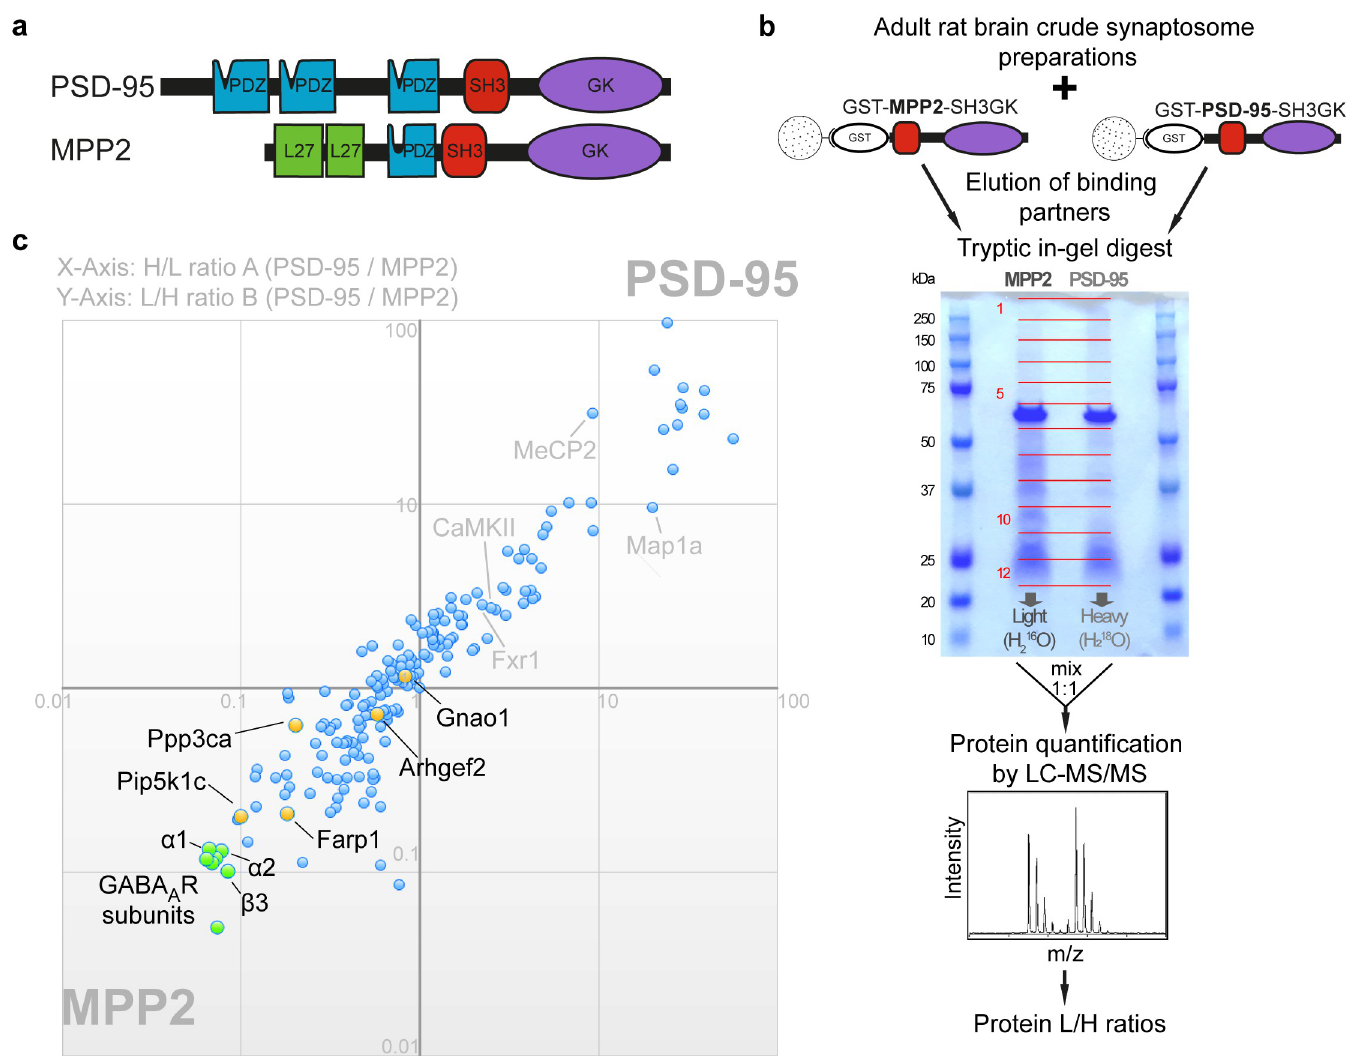
Fig 3. Identification of interactors that differentially bind to the carboxyl-terminal SH3GK modules of MPP2 and/or PSD-95. (a) Schematic domain structures of PSD-95 and MPP2 drawn to scale and aligned by their central PDZ domain. Both proteins contain two N-terminal domains (PDZ1+PDZ2 for PSD-95 and two L27 domains for MPP2) in addition to the carboxyl-terminal “MAGUK core” domains PDZ-SH3-GK. Note the differences in the length of the “linker” between PDZ and SH3 domain and of the “hook” between SH3 and GK domains. (b) Schematic representation of the quantitative LC–MS/MS experiment using 16 O/ 18 O-labelling to identify differential interactors from adult rat brain crude synaptosomal preparations by GST pull-down of bacterially expressed GST-MPP2-SH3GK or GST-PSD- 95-SH3GK. (c) GST pull-downs were performed in duplicates with inverted labelling and 188 interacting proteins were identified and quantified by mass spectrometry passing our threshold settings. PSD-95/MPP2 protein ratios from both replicates A and B (normalised by the ratio of GST) are plotted against each other. Proteins in the first quadrant indicate preferential enrichment to PSD-95 (ratios >> 1), while proteins in the third quadrant indicate preferential enrichment to MPP2 (ratios << 1). Proteins with ratios of approximately 1 show no preferential binding and thus reflect equal binding to both baits or background proteins that were not fully removed by the washing steps. Selected novel potential interaction partners were validated by co-immunoprecipitation (yellow, see also S6 Fig). The most significantly enriched proteins to the GST-SH3GK construct of MPP2 (green cluster) are 7 different GABA A receptor subunits, of which α 1, α 2, and β 3 have been validated for direct interaction with MPP2 (see also Fig 4). For further details, see also Table 1 and S1 Data. GABA, γ -aminobutyric acid; LC–MS/MS, liquid chromatography with tandem mass spectrometry; MAGUK, membrane-associated guanylate kinase; MPP2, membrane protein palmitoylated 2; PSD, postsynaptic density.